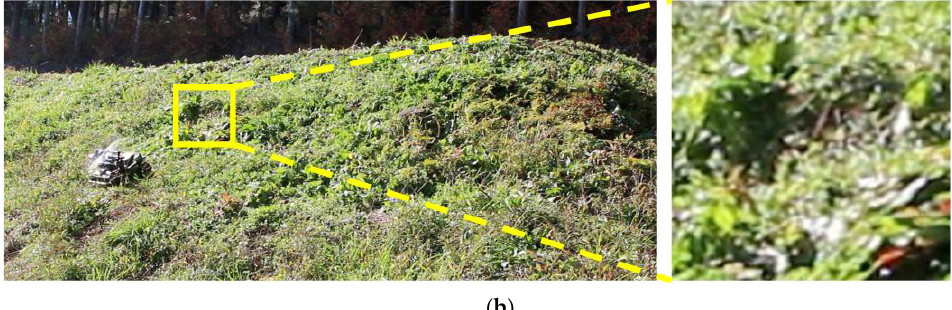
Figure 17. Grass cutting at different sites (slope angle 41 – 55°). ( a ) Before cutting the grass. ( b ) After cutting the grass.